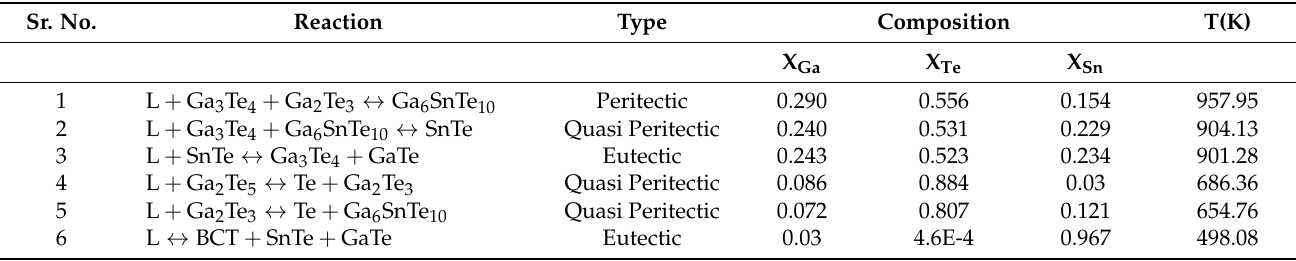
Figure 7. Calculated vertical section of ( a ) GaTe-SnTe and ( b ) Ga 2 Te 3 -SnTe quasi-binaries along with respective experimental data from [86–89]. Table 3. Invariant reactions in Ga-Sn-Te